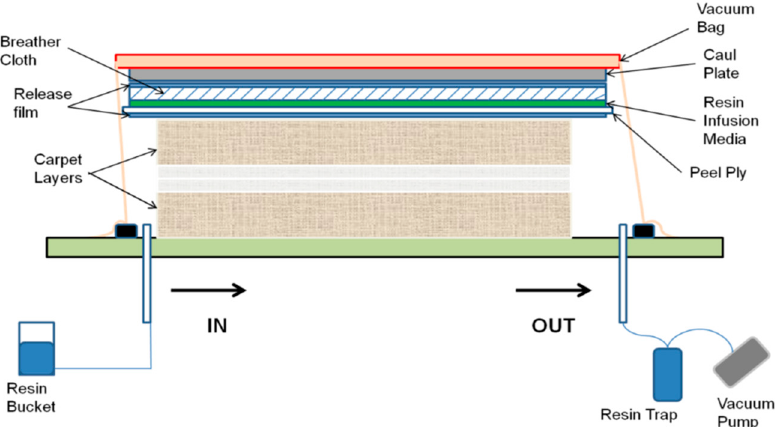
Figure 3. An illustrative schematic of the scaled-up VARTM process (elevation view).